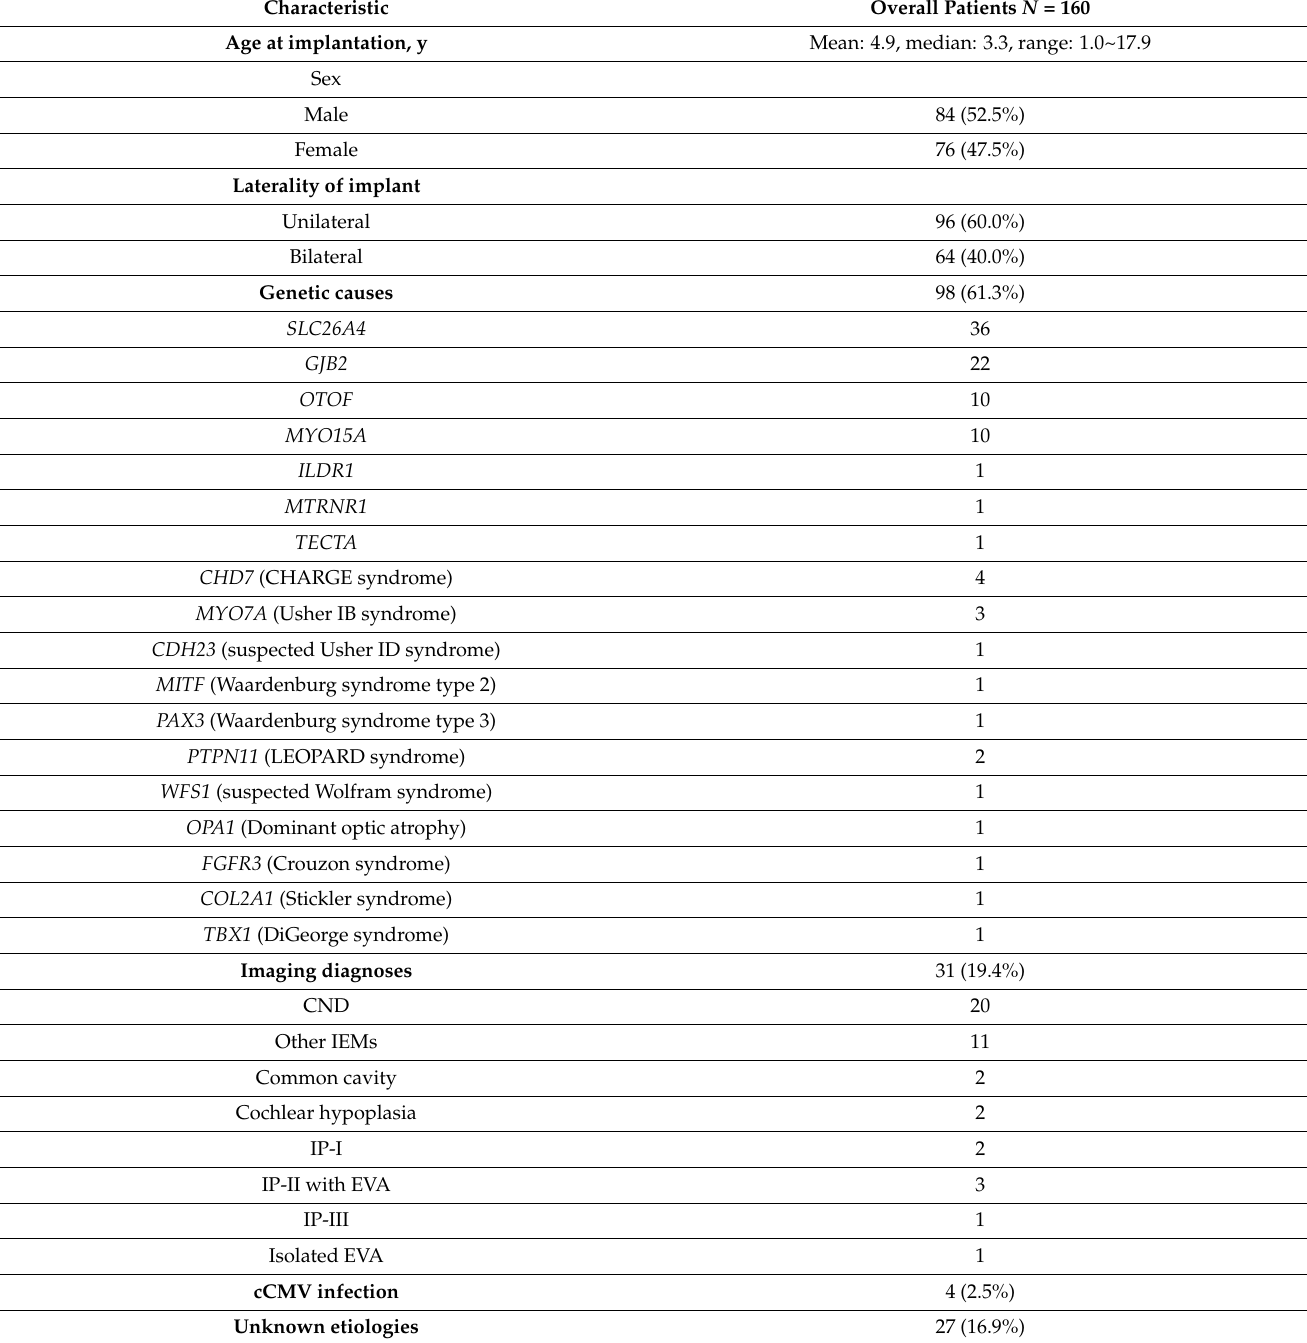
Table 1. Etiologies of the 160 cochlear